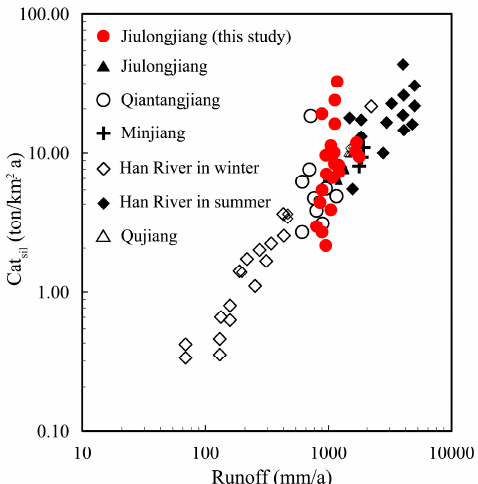
Figure 7. Relationship between Cat sil (silicate weathering rate based on cations) and runoff (discharge/area). Data from the Han River [51], Qiantangjiang [52] and southeast coastal rivers of China (Jiulongjiang River, Minjiang and Qujiang River) [27].